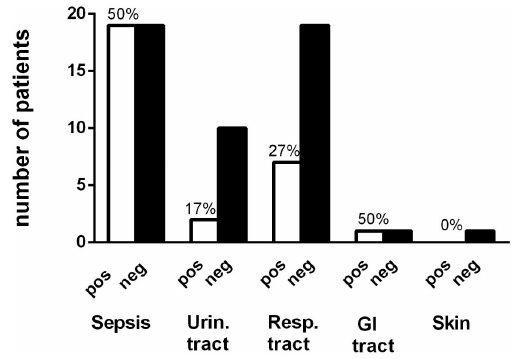
Figure 1. Effect of antibiotics at different infection indications in end ‐ of ‐ life cancer patients.